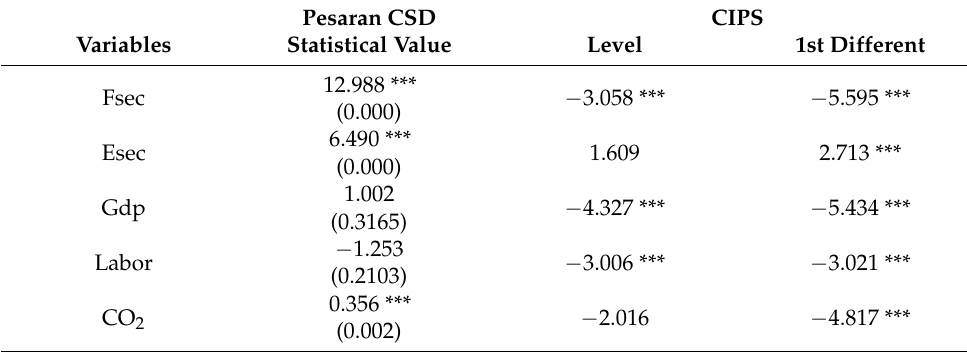
Table 4. Cross-sectional dependence and unit root tests.